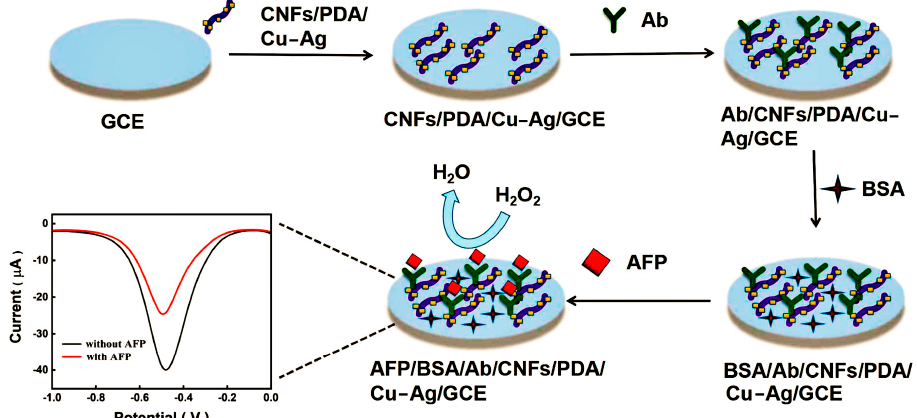
Figure 12. Schematic illustration of the electrochemical immunosensor preparation [99]. Copyright (2022) Elsevier.